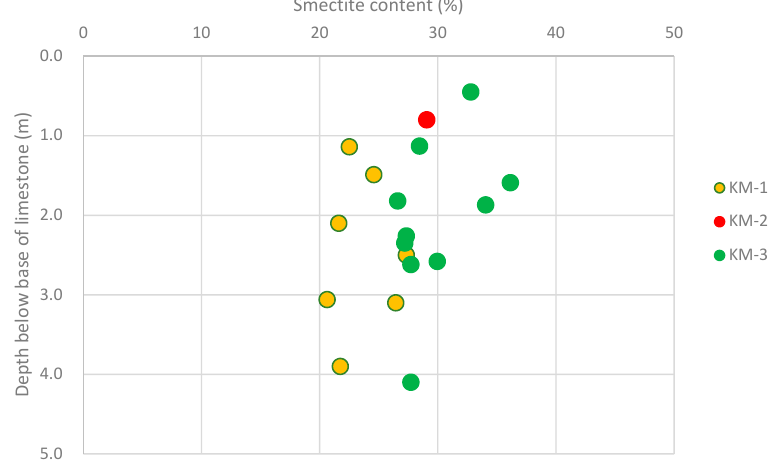
Figure 13. Calculated smectite content in samples from boreholes KM1, KM2 and KM3 versus depth below the base of the limestone overburden.